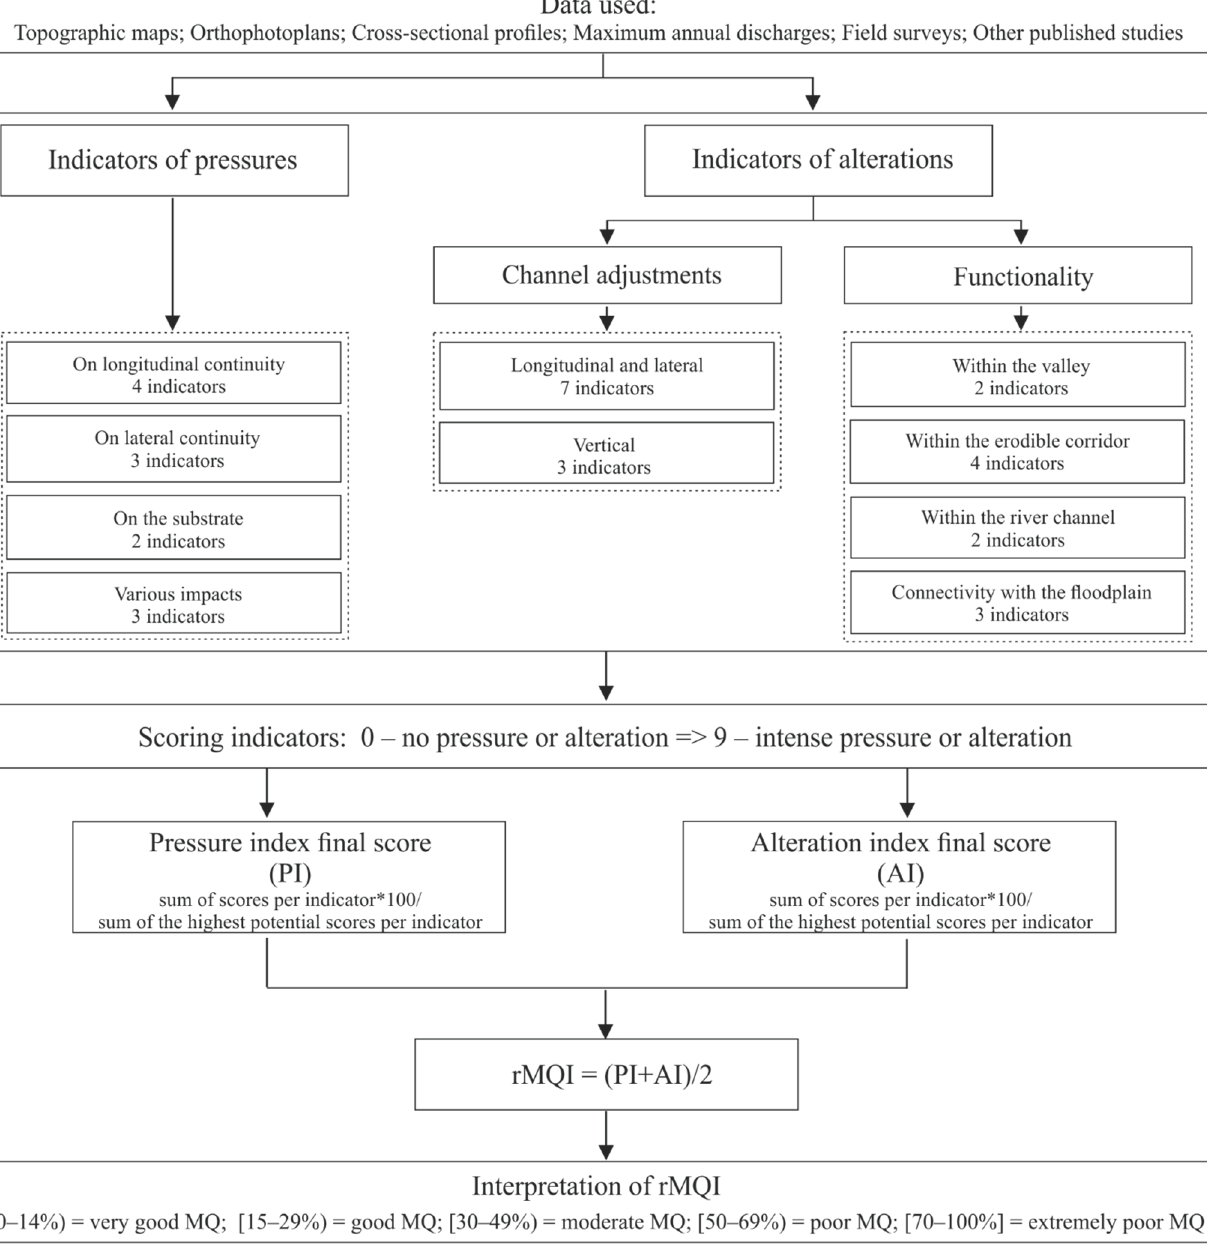
Figure 2. Flowchart of a methodological protocol of the revisited Morphological Quality Index (rMQI); data and scoring for each indicator are in Supplementary